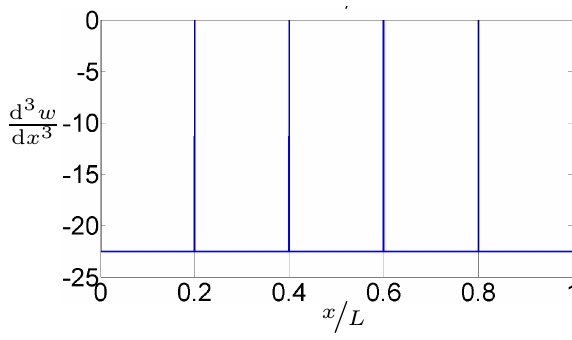
Table: Dimensions, loads and material parameters